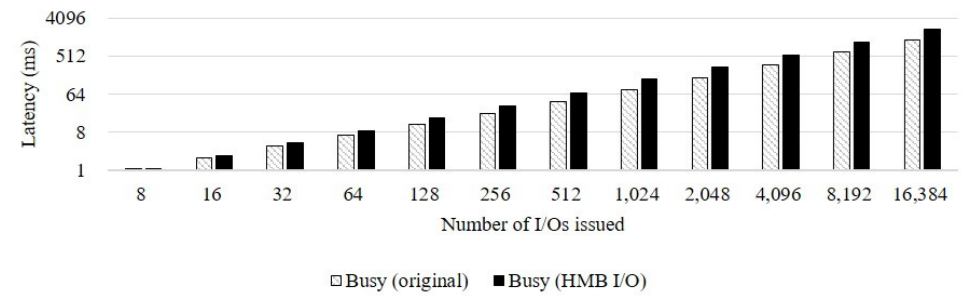
Figure 11. Average I / O latency of fio.